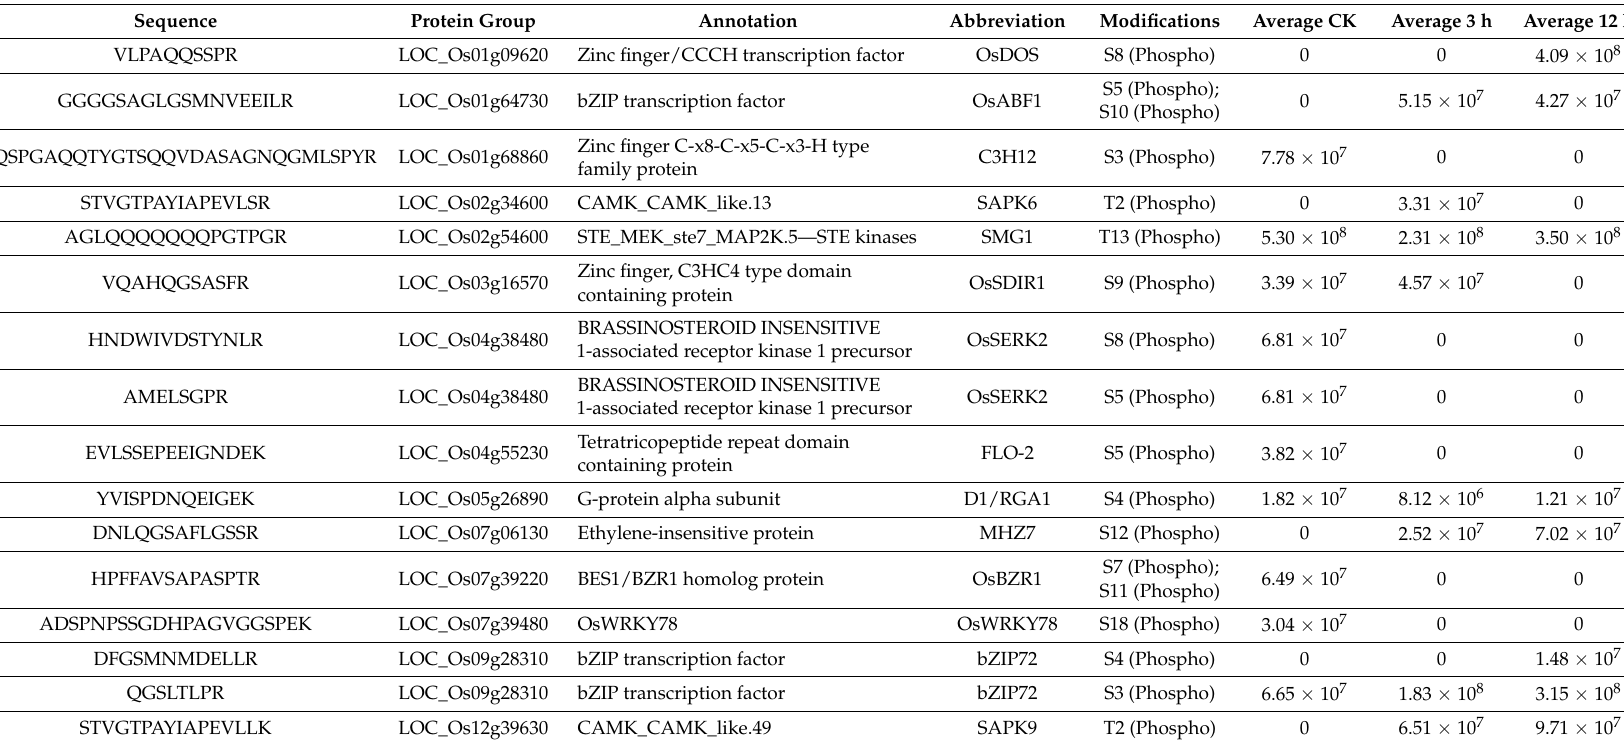
Table 1. Some selected examples of the differentially phosphorylated (DP) proteins identified under abscisic acid (ABA)